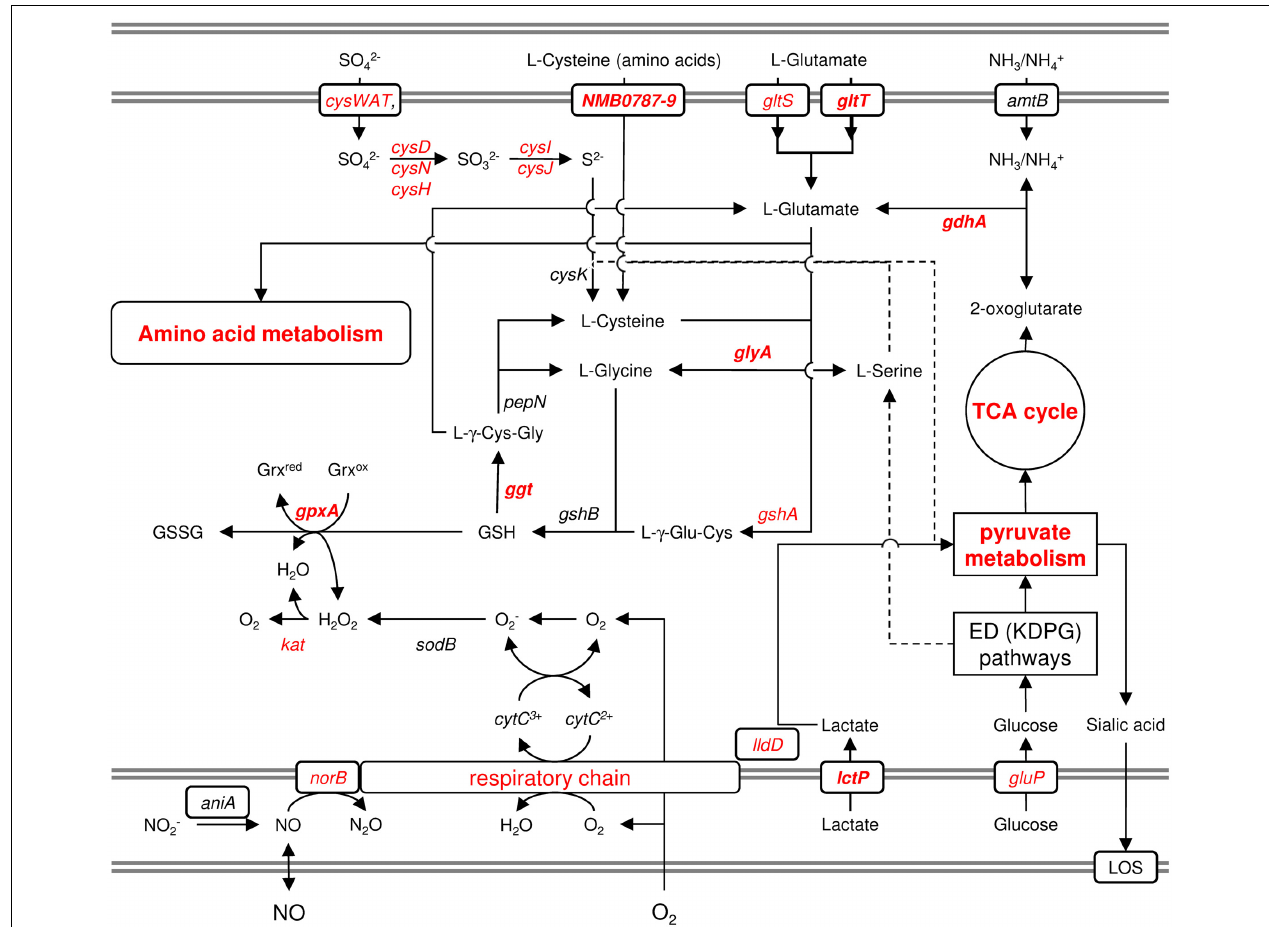
FIGURE 6 | Schematic graphical representation of the links between the oxidative stress response and the metabolism of lactate, cysteine and glutamine. This figure illustrates just the genes and pathways described in the text and does not give a comprehensive overview of the entire metabolism and stress responses of N. meningitidis . The gray double-lines